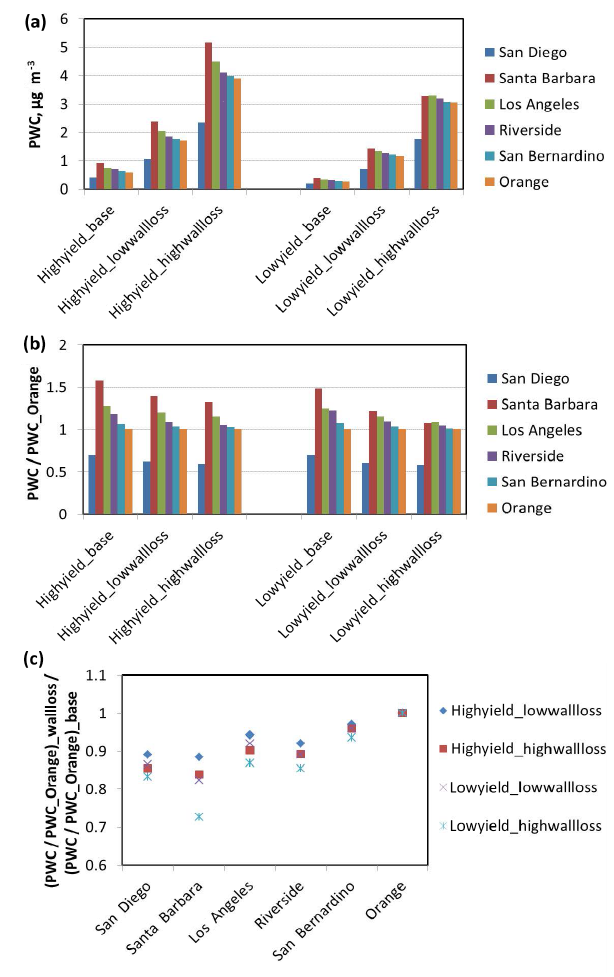
Figure 9. (a) Predicted population weighted concentrations (PWCs) of SOA in six counties in Southern California. Two sets of sim- ulations (scenarios) conducted by Cappa et al. (2016) were used, one with the low-NO x , high-yield parameters (denoted as “high- yield”) and the other with high-NO x , low-yield parameters (de- noted as “lowyield”). Each set of simulations included three vapor wall loss cases, i.e., no considering of vapor wall losses (denoted as “base”), low vapor wall loss rates (denoted as “lowwallloss”), and high vapor wall loss rates (denoted as “highwallloss”). (b) Normal- ized PWCs of SOA in all counties to the PWC of SOA in Orange County. (c) Changes in the normalized PWCs of SOA in all counties by accounting for vapor wall